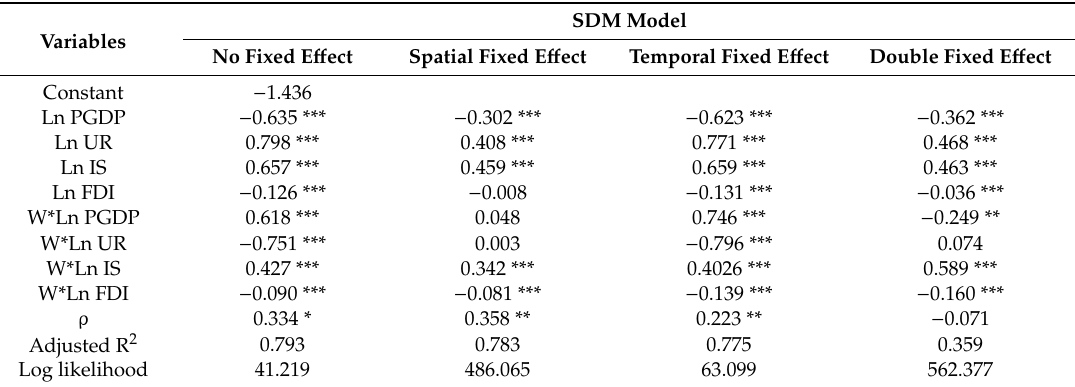
Table 6. Estimation results based on the spatial Durbin model (SDM).